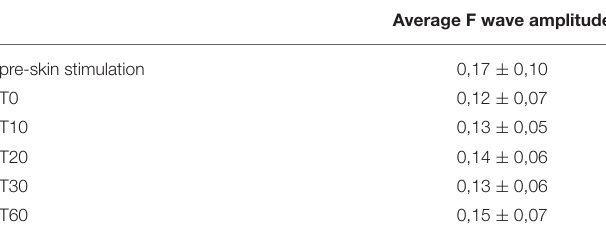
TABLE 2 | Average F-wave amplitude ± SD in the different time